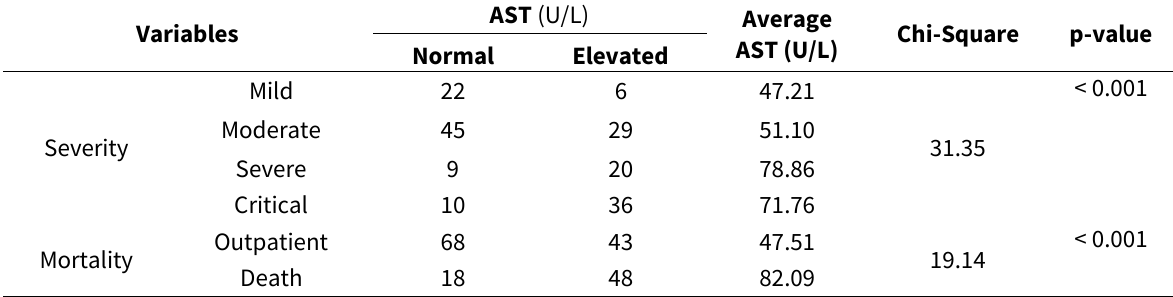
Table 2. Relationship of Increased AST on Severity and Mortality .